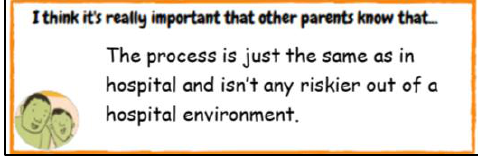
Figure 4. An example of a ‘ typed ’ response .